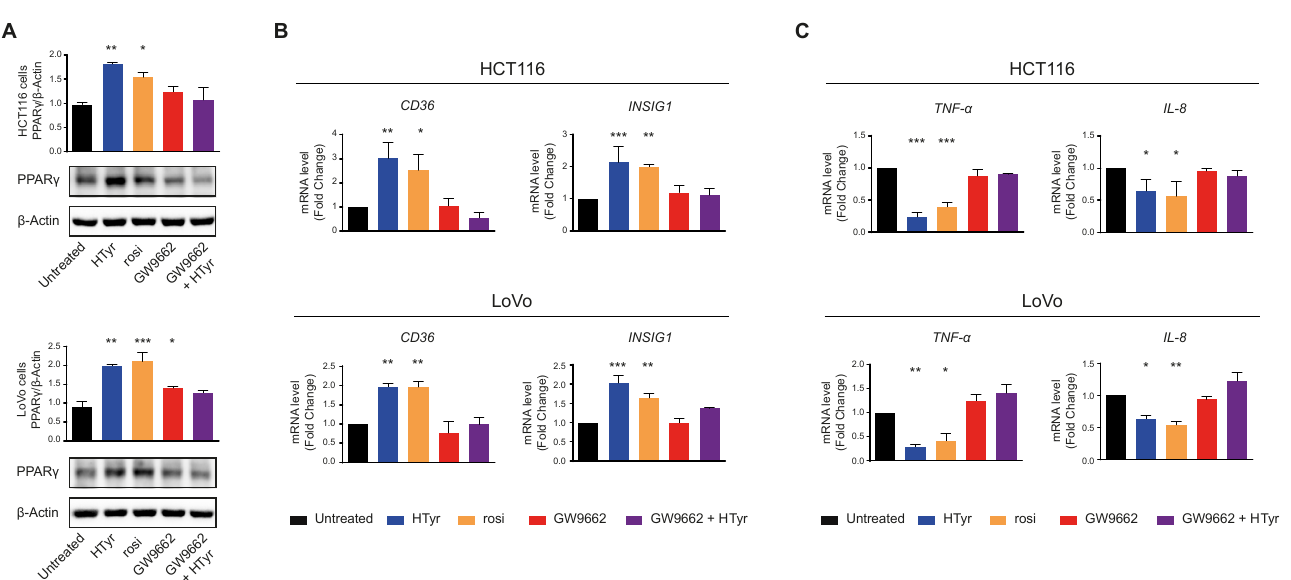
Figure 9. PPAR γ mediates the anti-inflammatory effects of hydroxytyrosol and OPWPs extracts in colorectal cancer cells: ( A ) Western blot analysis of PPAR γ in cells treated with HTyr (0.0154 mg mL − 1 for HCT116 cells and 0.0231 mg mL − 1 for LoVo cells), rosiglitazone (1 μ M) or GW9662 (10 μ M), or with HTyr and GW9662 in combination for 72 h and compared to untreated cells. The histograms illustrate the ratio of PPAR γ to β -Actin used for normalization. ( B ) Quantitative real time PCR analysis of CD36 and INSIG1 mRNAs in both cell lines treated as in ( A ) and compared to untreated cells. ( C ) Quantitative real time PCR analysis of TNF- α and IL-8 mRNAs in both cell lines treated as in ( A ) and compared to untreated cells. Statistical significance is considered when * p ≤ 0.05, ** p ≤ 0.01, *** p ≤ 0.001 (ANOVA with Dunnett’s post-test).